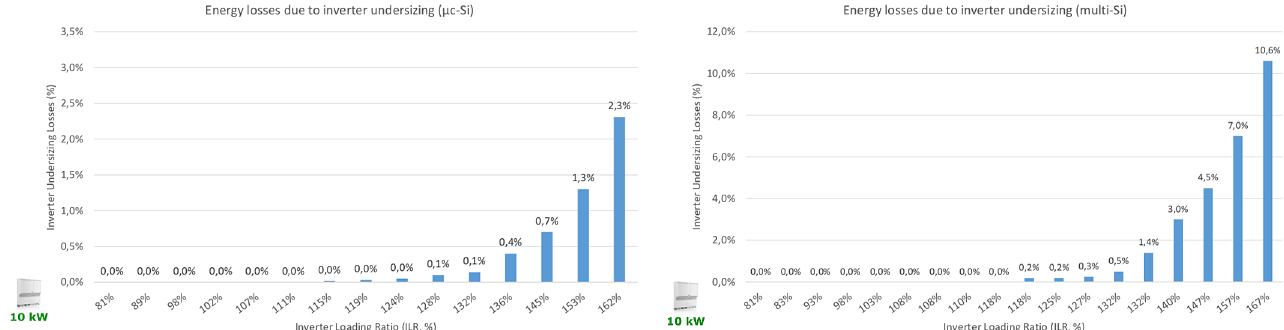
Fig. 8. Annual energy losses due to the Inverter Loading Ratio (ILR in %) measured at the 3MWp R&D PV power plant for the thin fi lm a-Si/ m c-Si (left) and multi-Si (right)